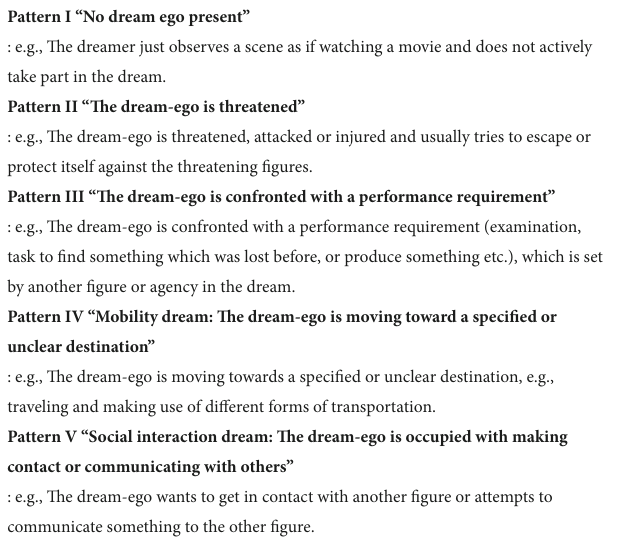
TABLE 1 The seven general structural patterns of structural dream